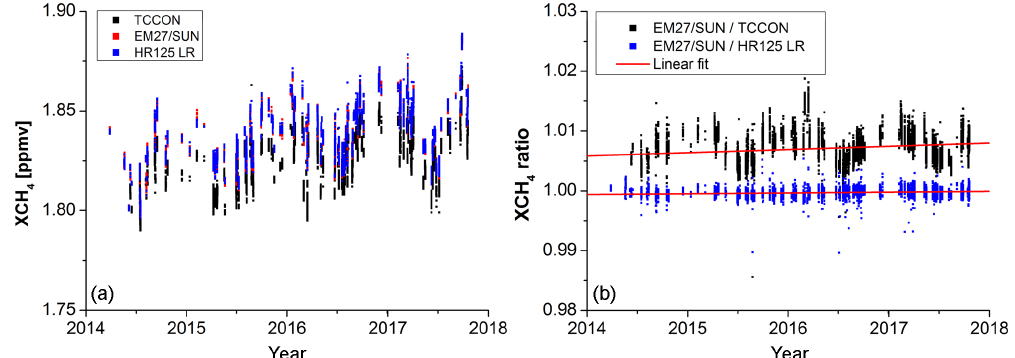
Figure 6. (a) shows the XCH 4 time series measured at KIT in Karlsruhe for the three data sets from March 2014 to October 2017. For clarity, only coincident measurements (within 1min) of the data sets are plotted. (b) shows the XCH 4 ratio between the EM27/SUN and the two HR125 data sets. A linear fit was applied to investigate a possible trend in the ratios.